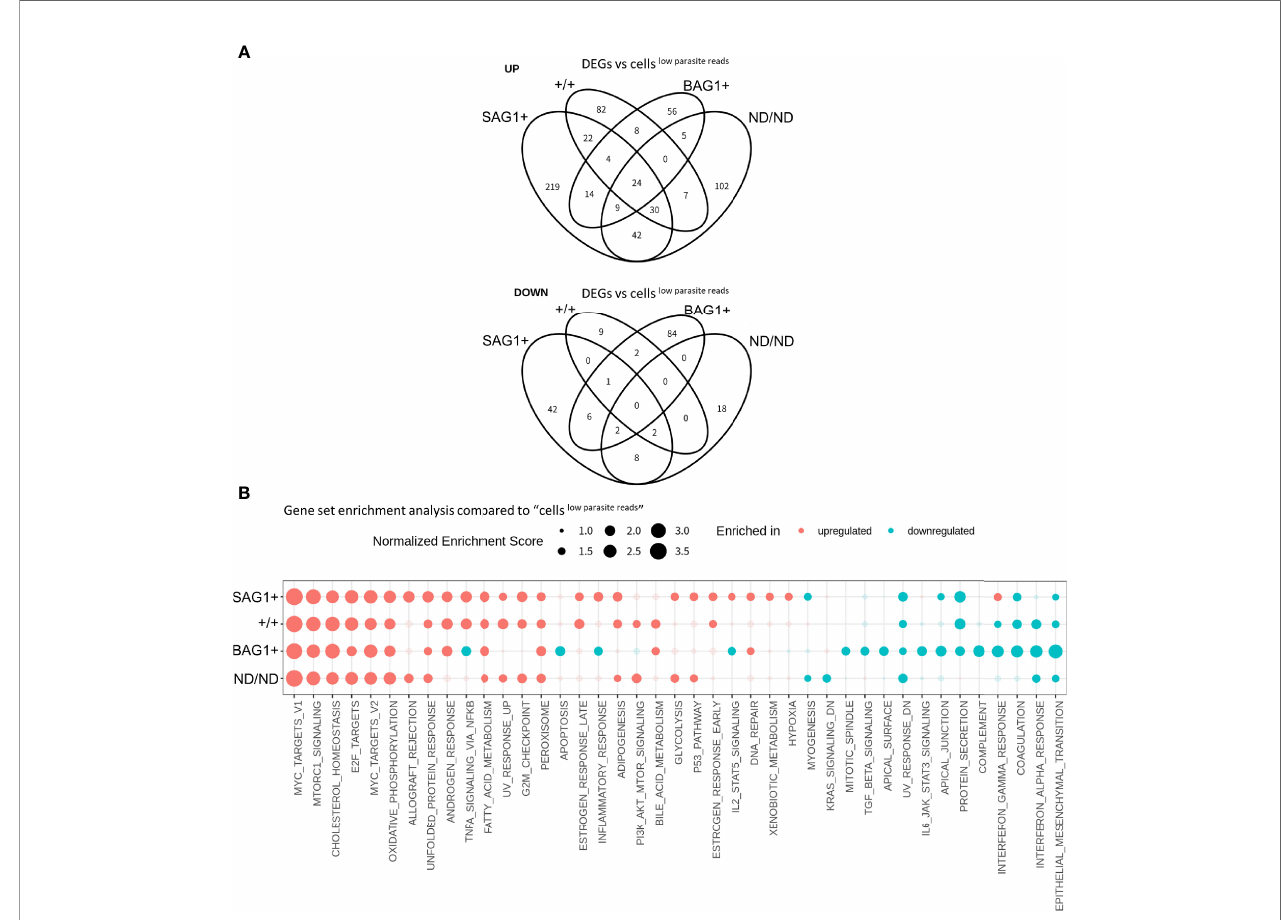
FIGURE 5 | Host transcriptome alteration is dependent on the parasite differentiation status. (A) DEGs detected in host cell subsets (BAG1+, SAG1+, +/+, ND/ND respectively) vs. cells low parasite reads were compared in Venn diagrams. Log 2 fold change of 0.5 and FDR of 0.05 were used to estimate DEGs. Number in the circle indicates number of DEGs. (B) Normalized enrichment score for gene set enrichment analysis (GSEA) are shown. Enriched pathways for upregulated genes are shown in red and those for downregulated genes are shown in blue. Enriched pathways with FDR less than 0.05 in at least one of the comparisons are shown. Pathways with FDR < 0.05 are shown with solid